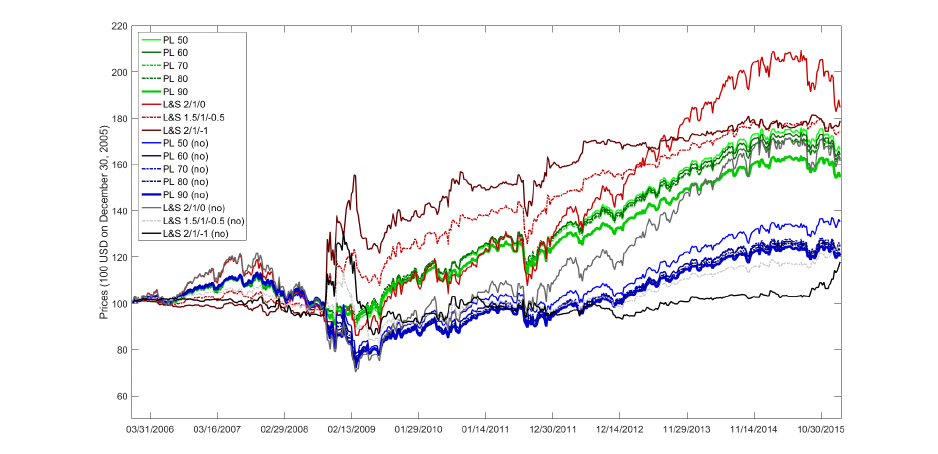
Figure A6. Decomposition of S&P500 log-returns predicted for next week, when the panel data is restricted to complete time series.